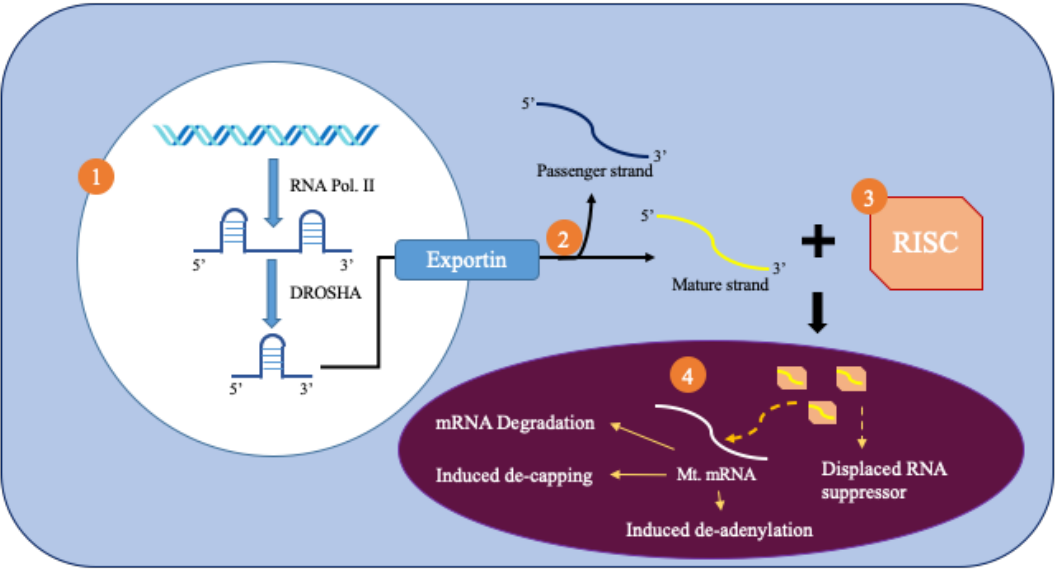
Figure 2. Production and import of mitomiRNA.